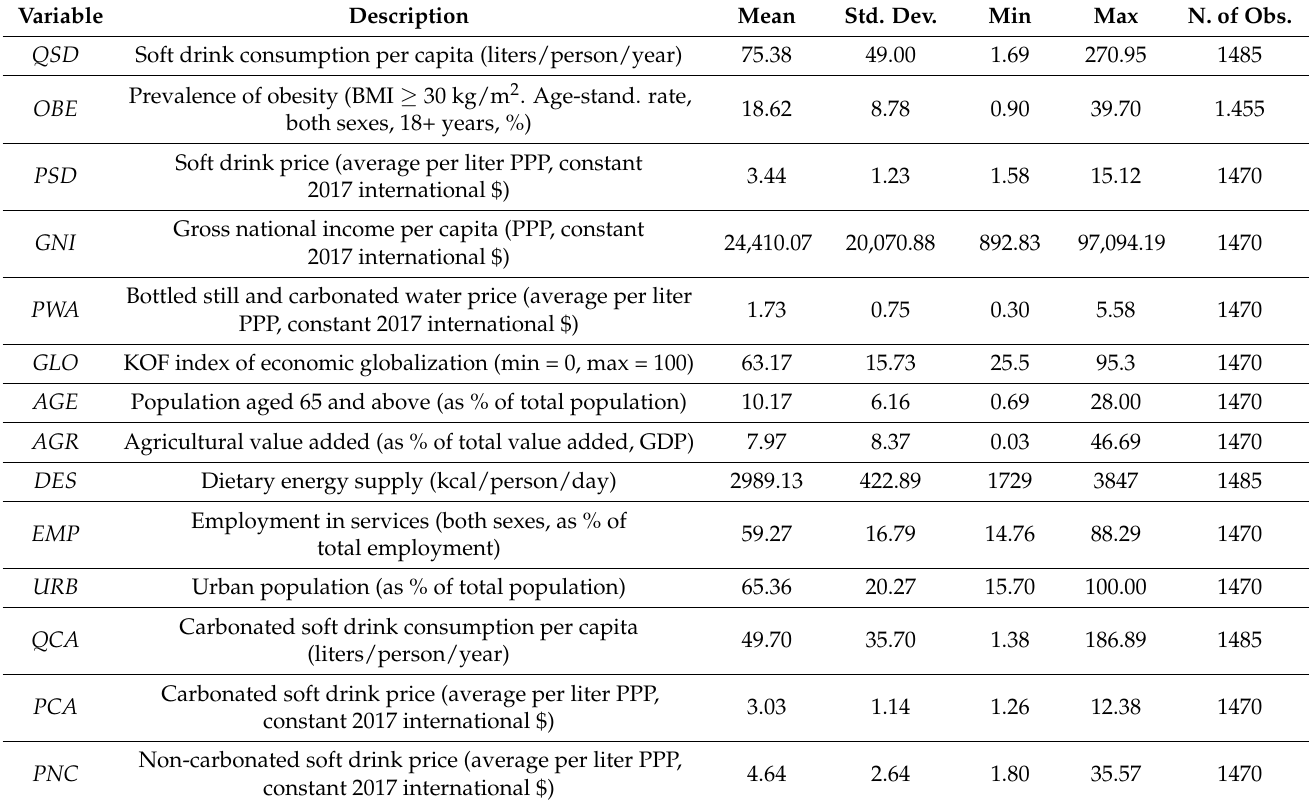
Table 1. Summary of variables and descriptive